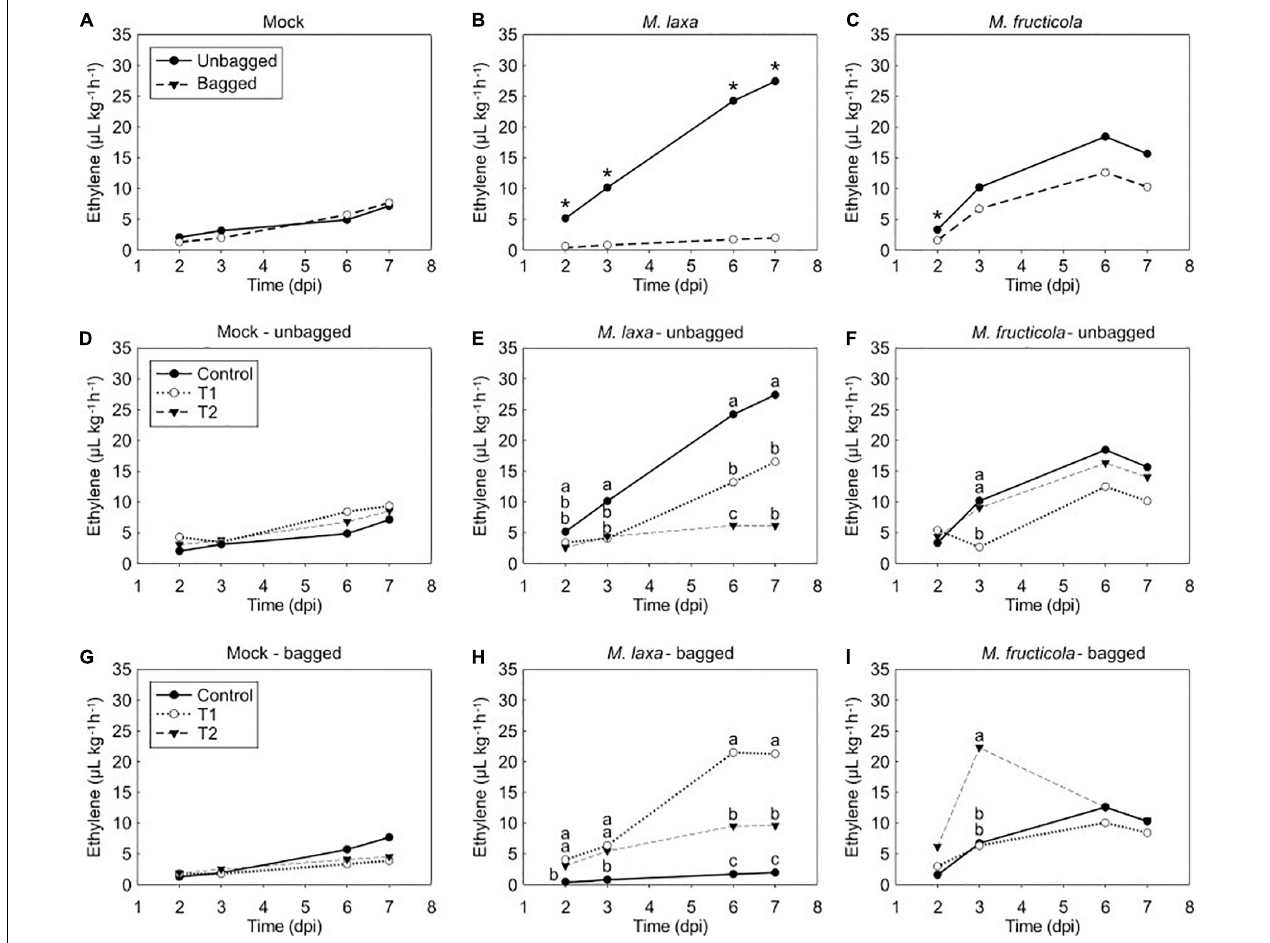
FIGURE 5 | Ethylene production of mock fruit, M. laxa - and M. fructicola- fruit interaction among bag and lighting treatments through time in “Fantasia” nectarines. Ethylene measurements of mock (A) , M. laxa- fruit (B) and M. fructicola- fruit (C) along the infection time course (dpi, days post-inoculation) under control condition (constant darkness). Symbols (*) indicate significant differences between bagging conditions at each time point according to Student’s T -test ( P ≤ 0.05). Ethylene measurements in mock fruit (D,G) , M. laxa- fruit (E,H) and M. fructicola- fruit (F,I) in unbagged (D–F) and bagged conditions (G–I) along the infection time course (dpi) under each lighting treatment. Different letters indicate significant differences ( P ≤ 0.05) among light conditions according to orthogonal contrasts at each time point. No letters indicate no significant differences. In all graphics, values represent the mean of ethylene measurements of each replicate ( n =